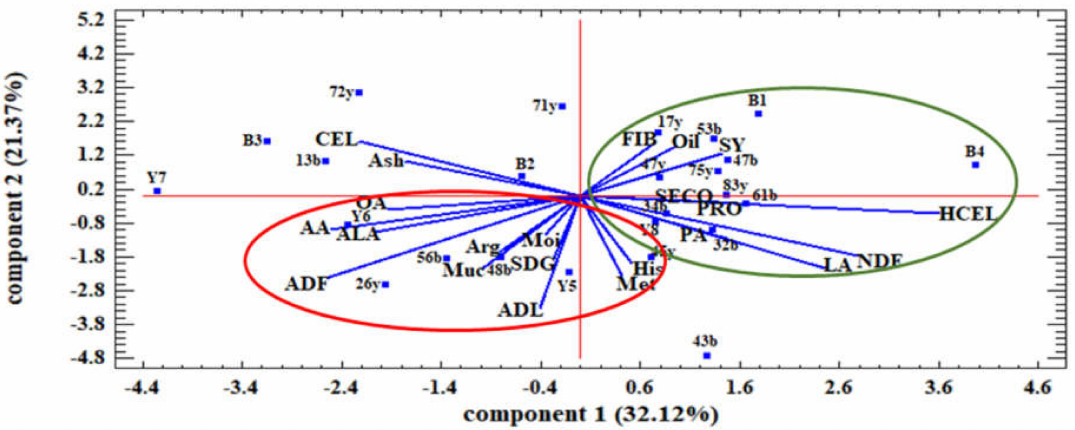
Figure 4. Principal component analysis of the relationship among the studied traits and the distribution of families of flax relative to these traits under normal water conditions. SY: seed yield. Oil: oil content. NDF: neutral detergent fibers. ADF: acid detergent fibers. ADL: lignin. CEL: cellulose. HCEL: hemicellulose. Muc: mucilage. PRO: protein content. FIB: fiber content. OA: oleic acid. LA: linoleic acid. PA: palmitic acid. ALA: α - Linolenic acid. Met: Methionine. His: histidine. Arg: arginine. AA: aspartic acid. Moi: moisture. SDG: secoisolariciresinol diglucoside. SECO: secoisolariciresinol.